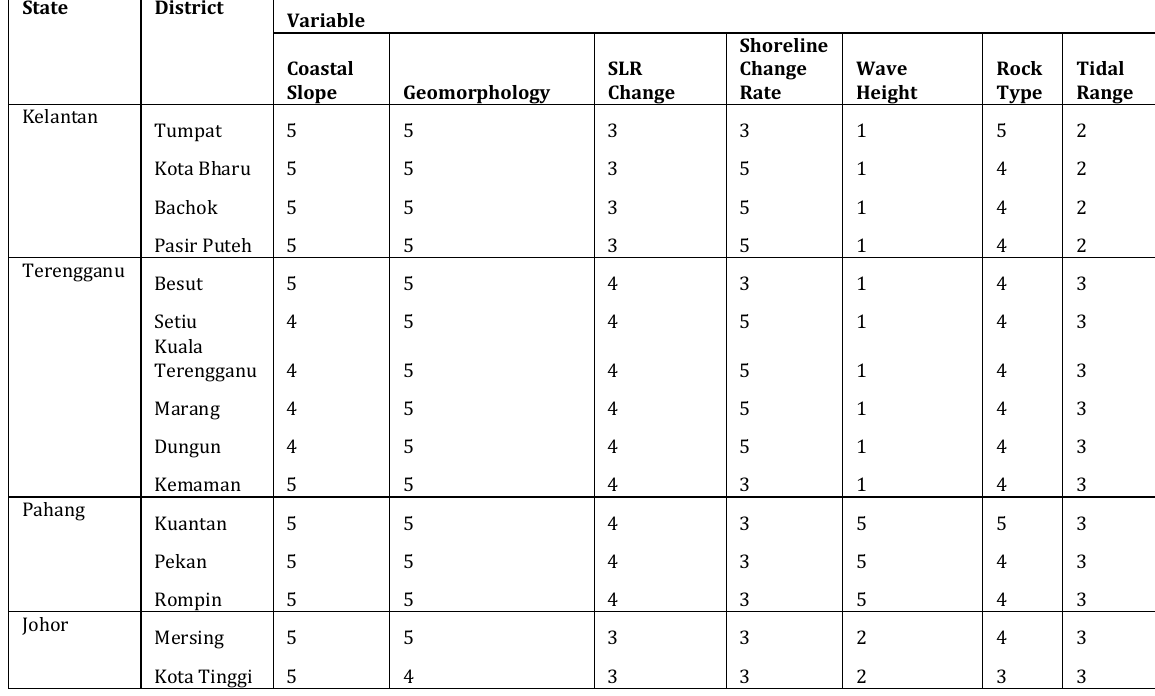
Table 9: Physical risk classes for each